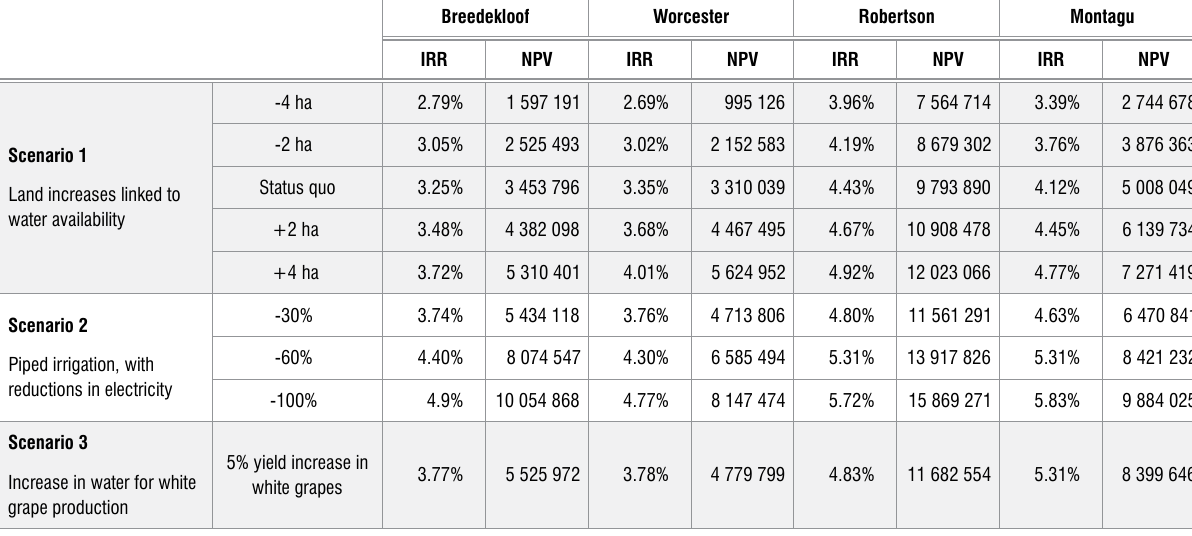
Effect on internal rate of return on capital investment (IRR, %) and net present value (NPV, ZAR) for selected water-related strategies for the ‘typical farm’ of each area on the Breede River, based on hypothetical scenarios Breedekloof worcester